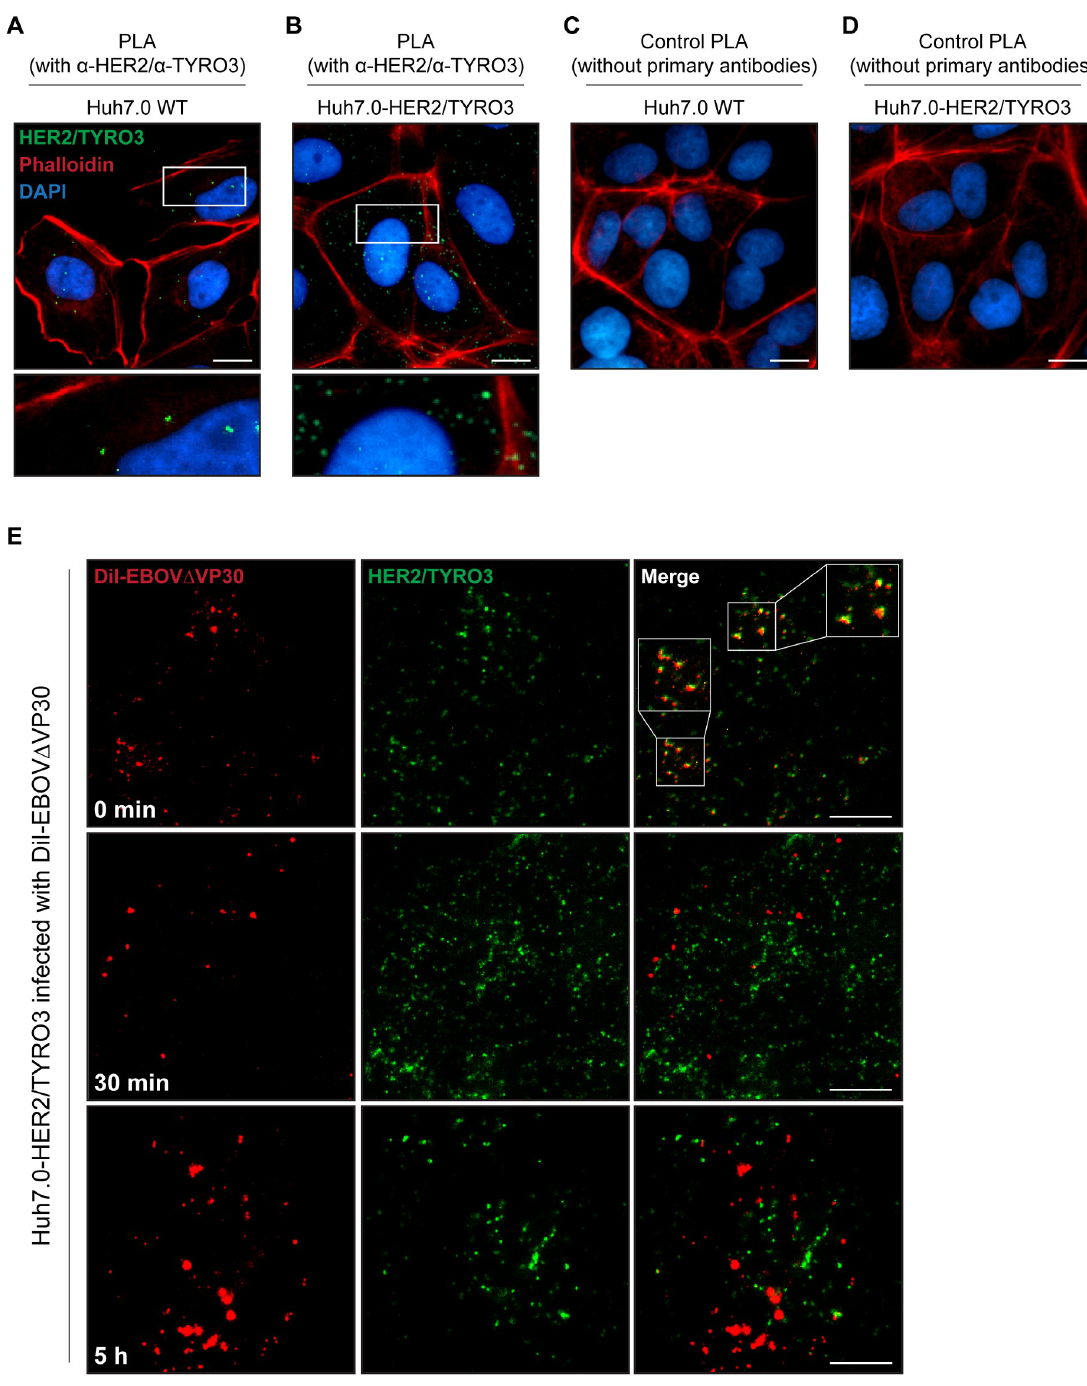
Fig 7. Localization of EBOV Δ VP30 particles with the HER2/TYRO3 complex. Interaction between HER2 and TYRO3 in Huh7.0 WT cells (A and C) and the Huh7.0 stable cell line that overexpress both HER2 and TYRO3 (B and D). HER2/TYRO3 complexes (green) were visualized by PLA using specific antibodies (A and B). Actin and nuclei were visualized with Phalloidin (red) and DAPI (blue), respectively. The enlarged images corresponded to the boxed areas shown under the original images. Scale bars, 20 μ m. (E) EBOV Δ VP30 particles (red) and HER2/TYRO3 complexes (green) in the Huh7.0 HER2/TYRO3 cell line infected with DiI-labelled EBOV Δ VP30 (DiI-EBOV Δ VP30) for 0 min (top panels), 30 min (middle panels), or 5 h (bottom panels). HER2/TYRO3 complexes were visualized by PLA using specific antibodies. The enlarged images corresponded to the boxed areas shown under the original images. Scale bars, 20 μ m.